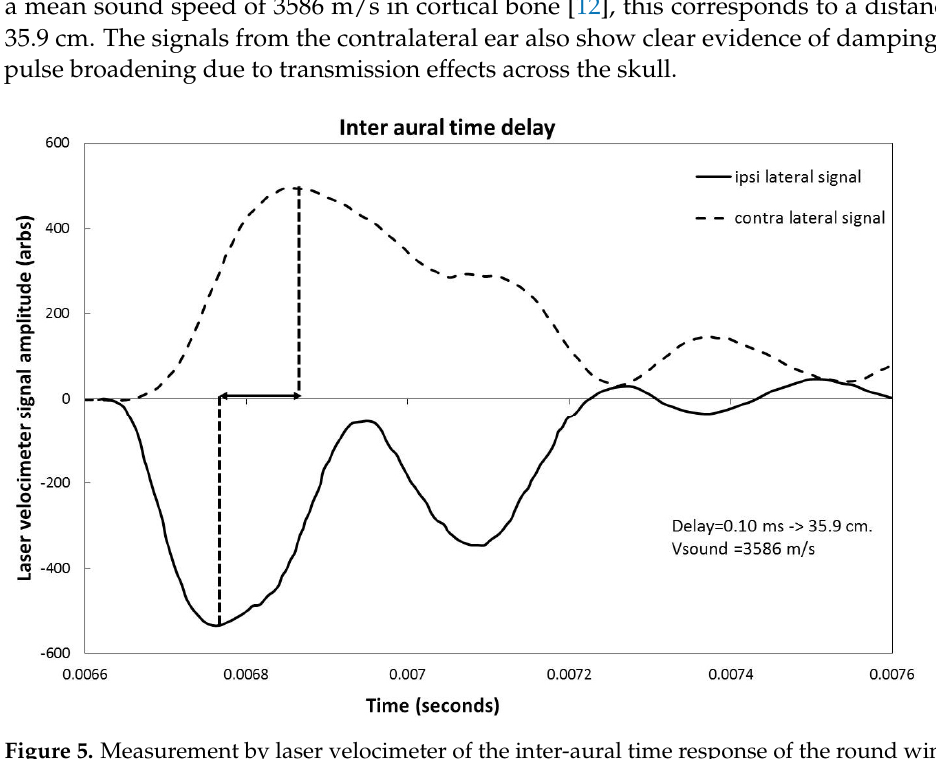
Table 1. Propagation properties of accelerators 5 and 3.